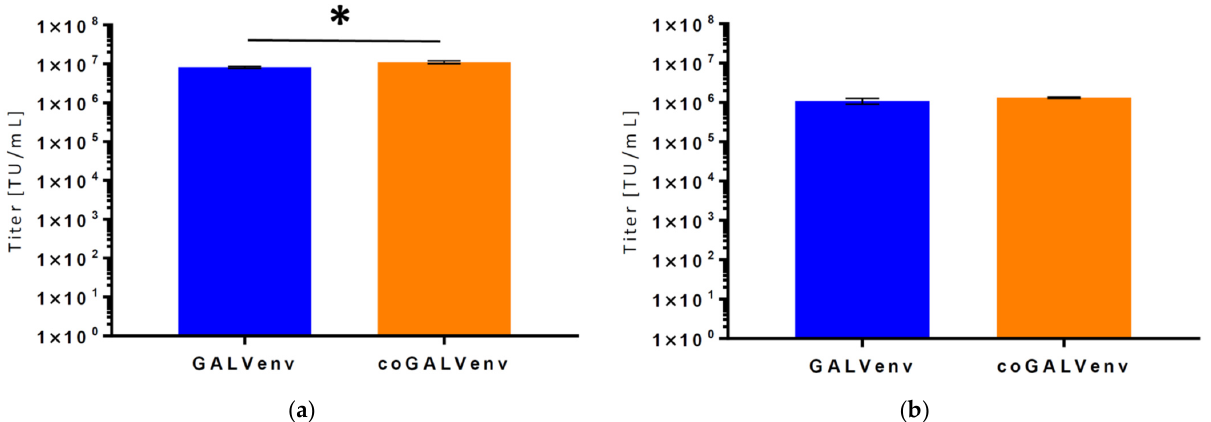
Figure 4. Titers of vectors produced in standard-scale with GALV-env and coGALV-env for γ -RVs and α -RVs. GALV-env-vectors were produced with 160 ng of plasmid/10 6 cells, coGALV-env-vectors with 20 ng of plasmid/10 6 cells. Titers of ( a ) γ -RVVs and ( b ) α -RVVs were determined on 293T cells. Data shown are the mean of triplicates. TU = transducing units, * p < 0.01 ( t -test).